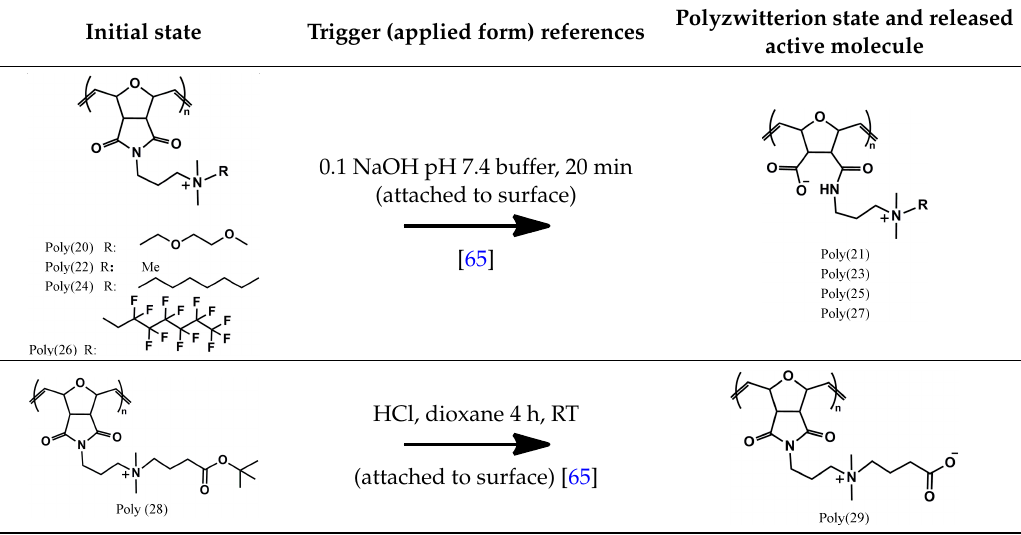
Table 4. Irreversible switches of norbornene polymers containing polyzwitterionic state.